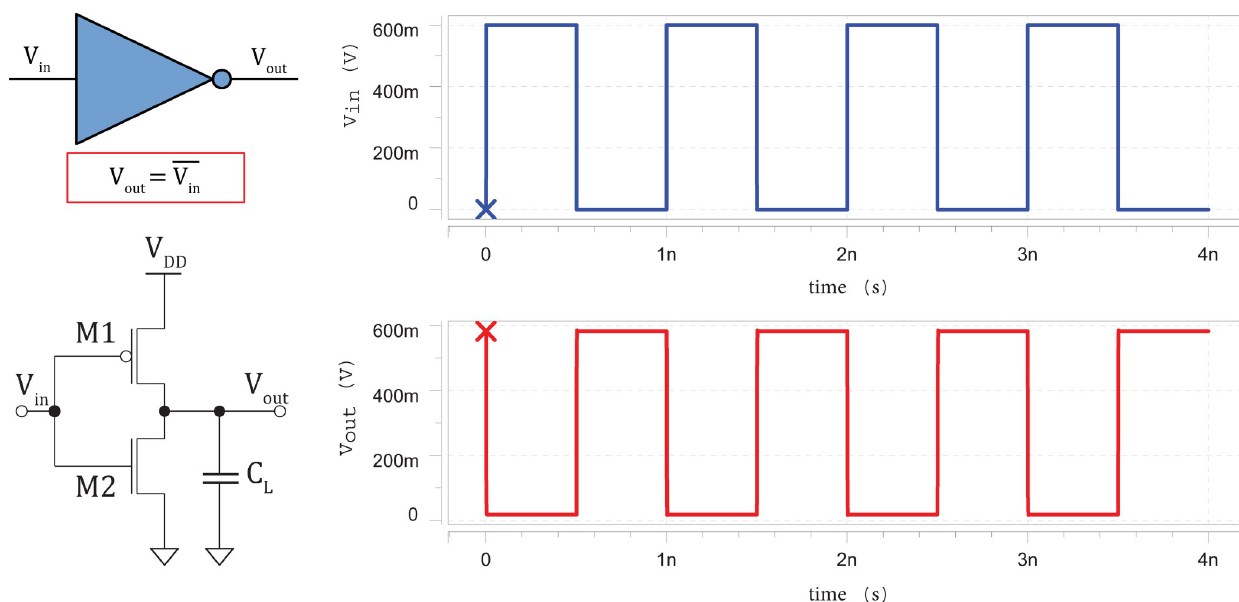
Fig 5. Schematic circuit diagram of silicene-based inverter ( L int = 1 μm ) with its input (blue) and corresponding output waveforms (red).